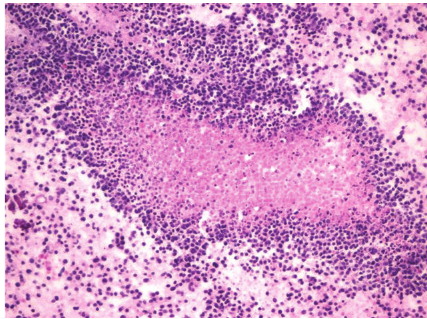
Figure 4: Cell block reveals viable small round cells surrounding a central focus of necrosis.